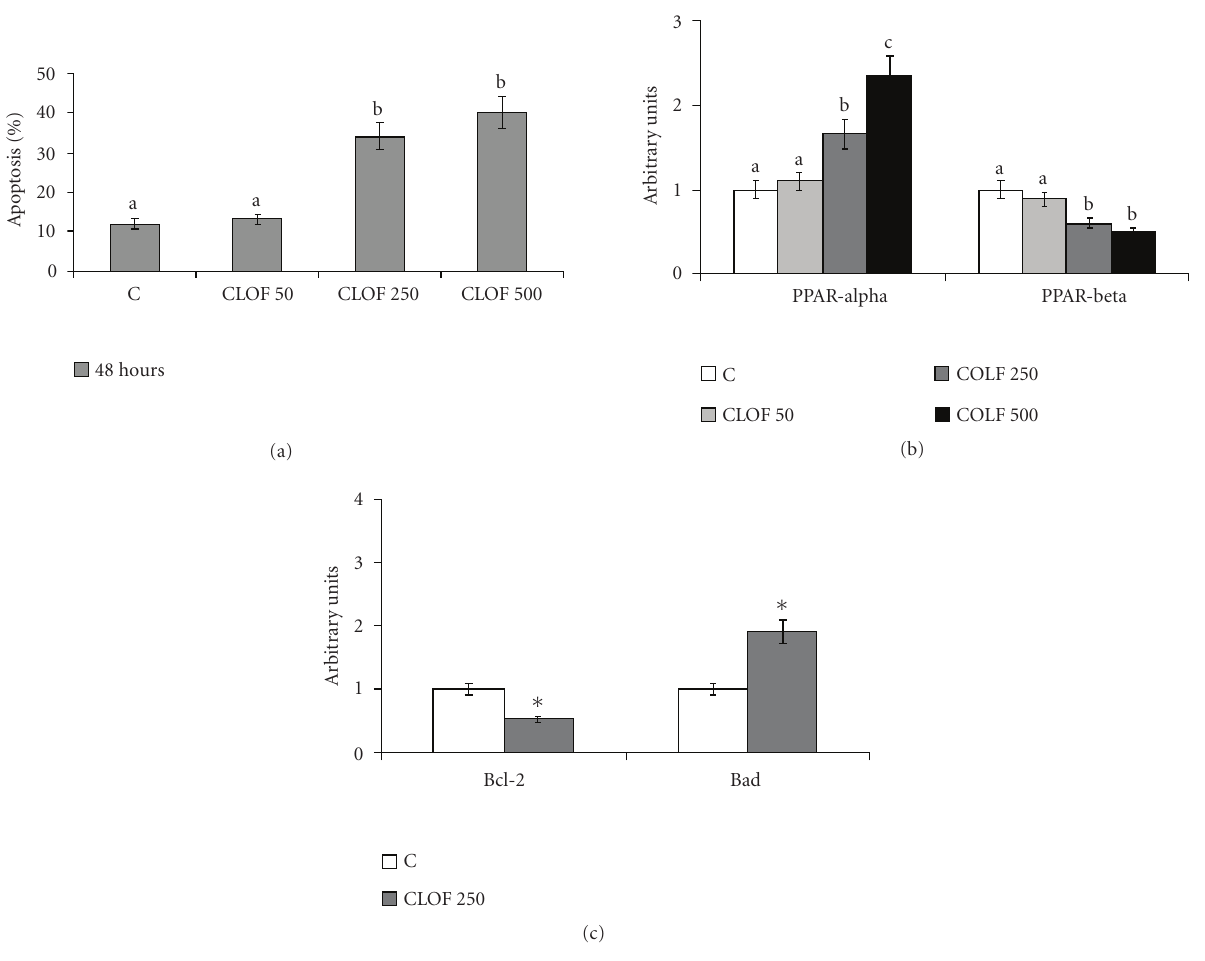
Figure 4: Apoptosis, and PPAR α , PPAR β , Bcl-2, and Bad protein contents, in human keratinocytes NCTC 2544 treated with clofibrate. (a) Apoptosis: 24 hours after seeding, cells were treated with 250 μ M clofibrate (CLOF) for a further 48 hours. Control cells were treated with vehicle alone. Apoptosis was determined by flow cytometric analysis. The percentages of apoptotic cells are presented as means ± SD of